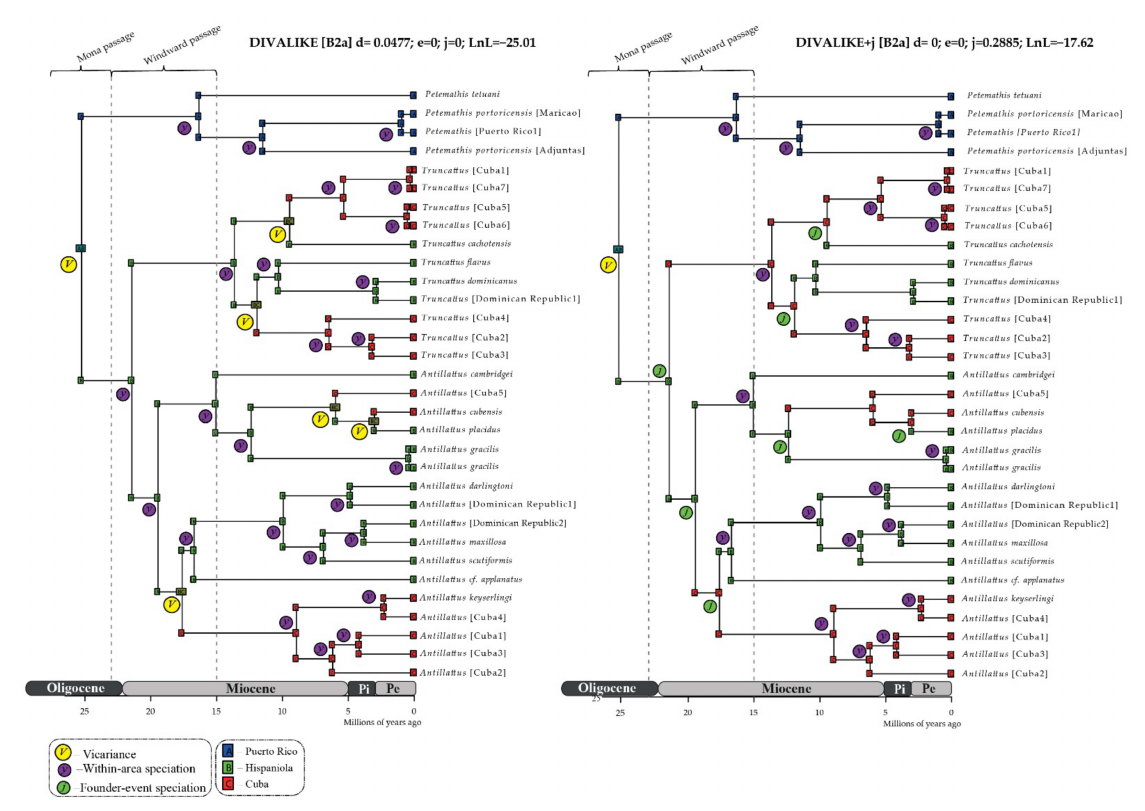
Figure 6. BioGeoBEARS phylograms corresponding to the time-stratified DIVALIKE and DIVA- LIKE+J B2a model (Table 1). The trees show the most probable geographic range pre- and post-split. The scale is in millions of years. Table 4. Summary count of time-constrained Biogeographic Stochastic Mappings. DIVALIKE and DIVALIKE +j. Abbreviations: j, jump dispersal or founder-event speciation; a, range-switching dispersal; d, range-expansion dispersal; e, extinction; s, sympatric-subset speciation; v, vicariance; y, within-area speciation; Ÿd, allopatric dispersal; Ad, anagenetic dispersal; Ÿa: allopatric anagenetic; Ÿc: allopatric cladogenetic; sums, adds up all of the events across the stochastic